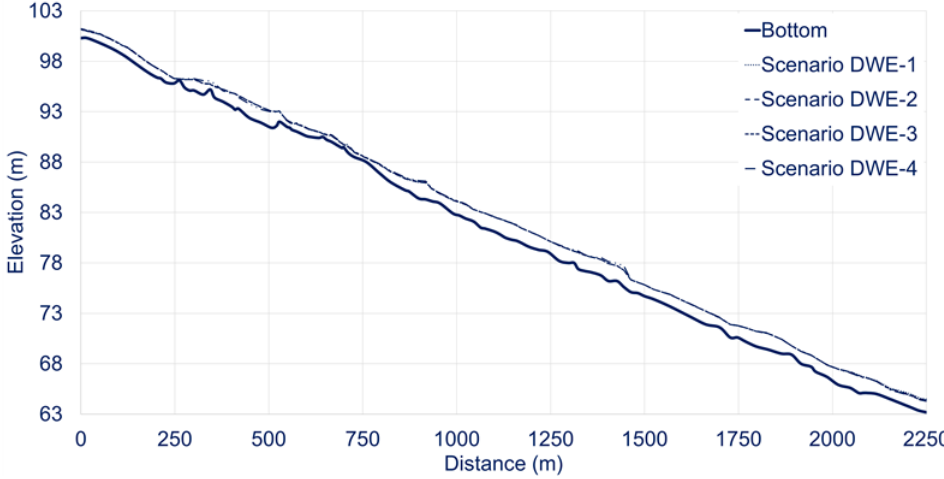
Figure 5. Comparison of water elevations along Koropouli Street for the DWE scenarios.